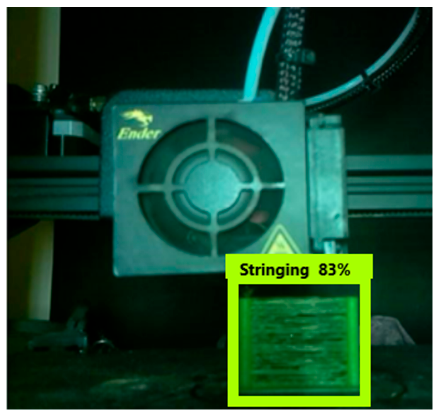
Figure 12. Live testing results with stringing error .